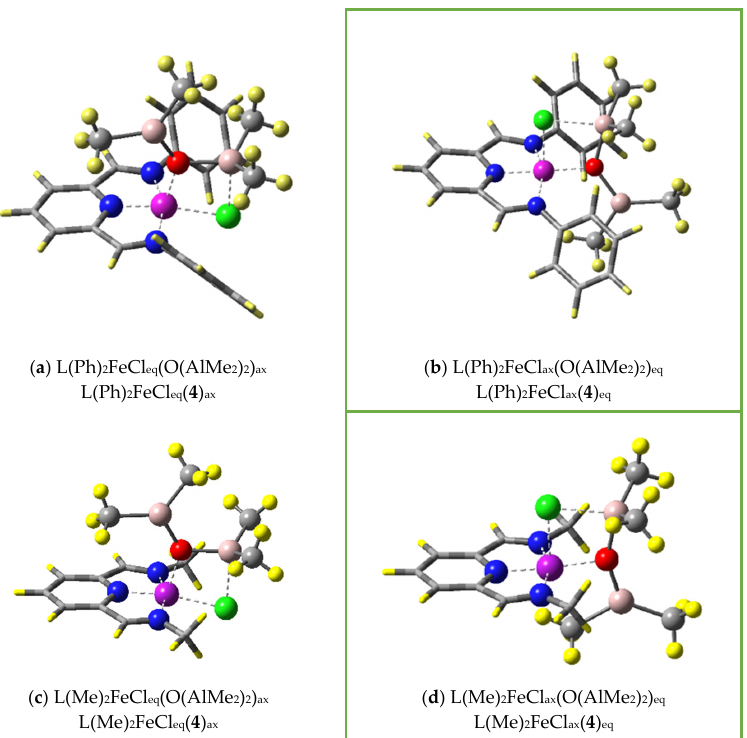
Figure 4. Computed structure of catalyst with the Sinn monomer 4 , O(AlMe 2 ) 2 a small acyclic aluminoxane. Top row: N , N -diphenyl ligand L; bottom row: N , N -dimethyl ligand L. Left column: equatorial chloride; right column: axial chloride.